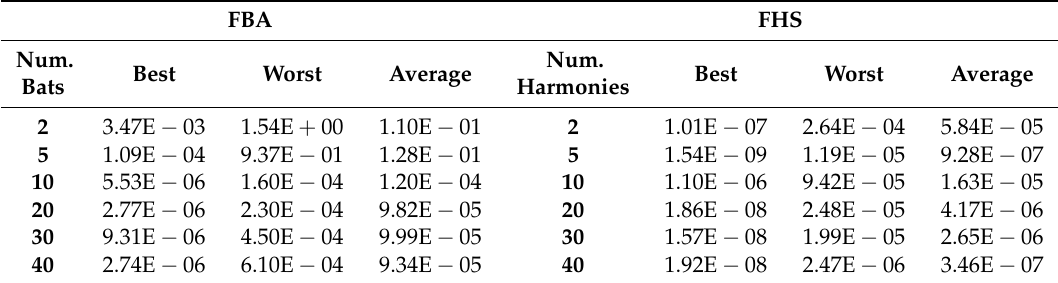
Table 13. Experiment results obtained for the sphere function with FBA and FHS algorithms. FBA FHS Num.